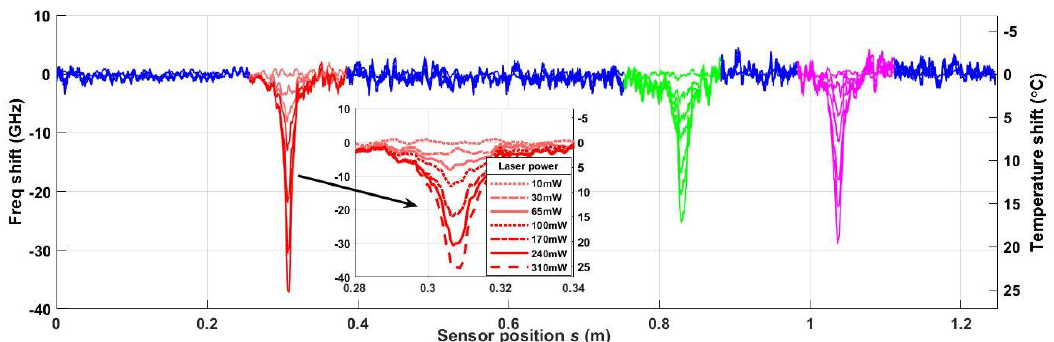
(cid:10) (cid:11) f ( s , t ) (left axis) and corresponding temperature shifts f s t (left axis) and corresponding temperature shifts t t